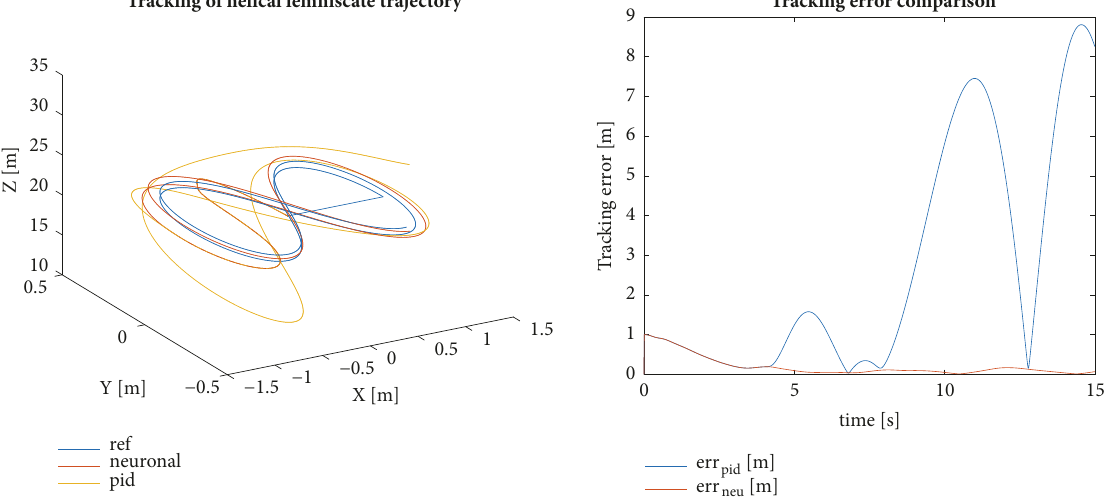
Figure 15: UAV tracking of a helical lemniscate trajectory with sinusoidal mass variation (left) and its tracking error (right).